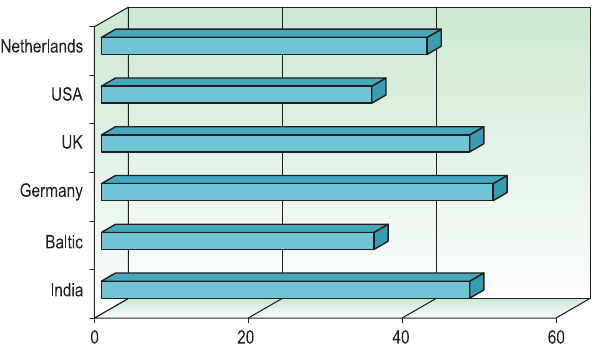
Fig. 4. Income tax and VAT, percent, 2007 Source: The complete worldwide tax & fi nance site